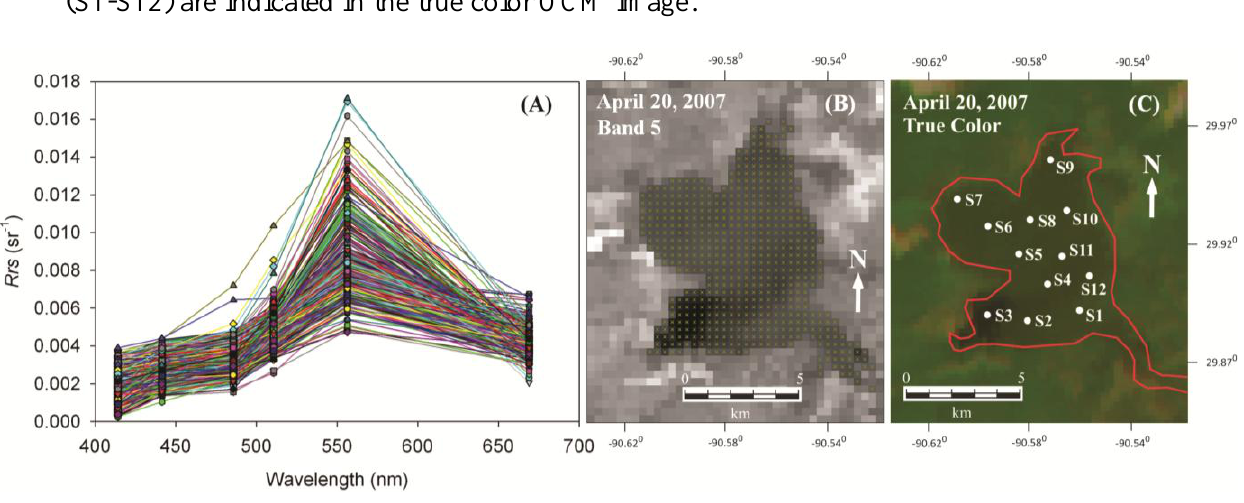
Figure 13. ( A ) R spectra of all the 572 pixels in Lac des Allemands for 20 April 2007. ( B ) rs The 572 pixels have been identified in the band 5 OCM image. ( C ) Twelve sampling sites (S1-S12) are indicated in the true color OCM